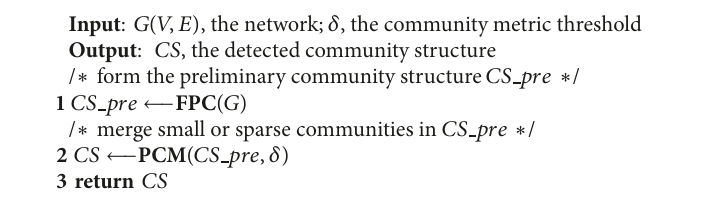
Algorithm 1: The framework of our proposed method,